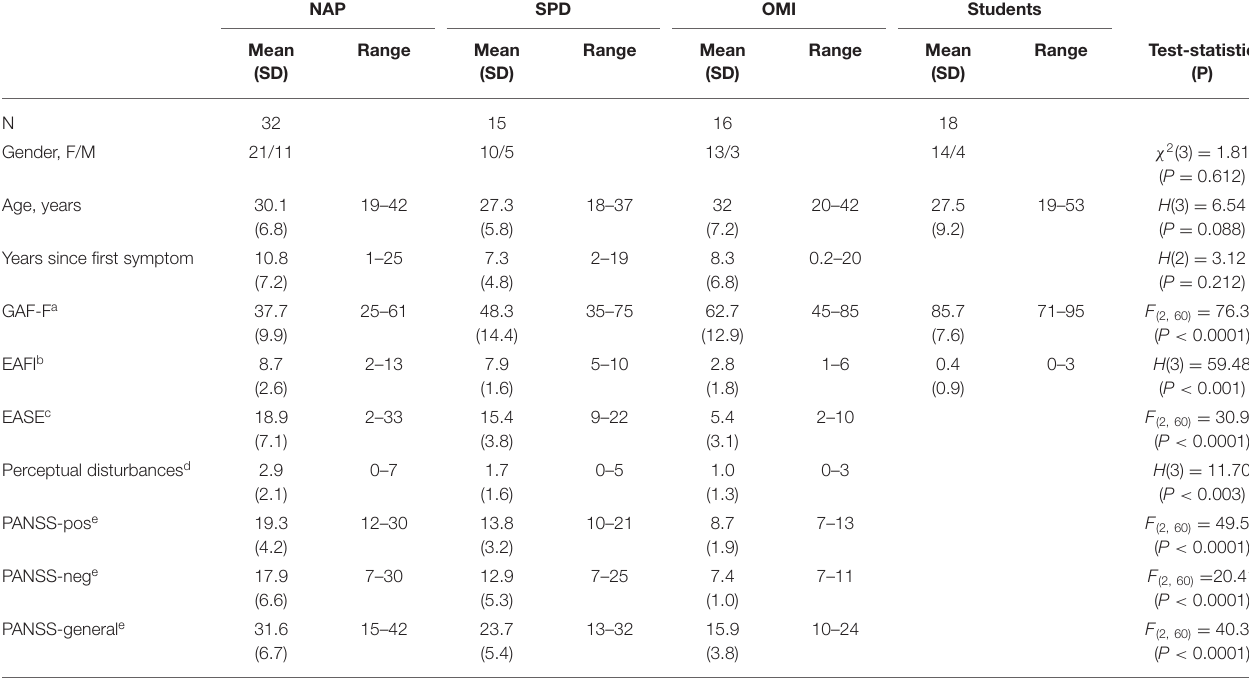
TABLE 1 | Sociodemographic characteristics of the sample and distribution of psychopathology in the groups.